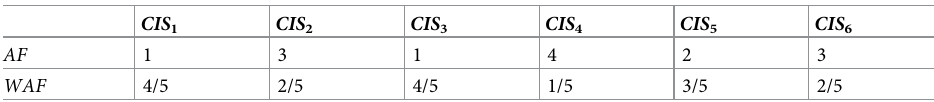
Table 3. Ranking of the